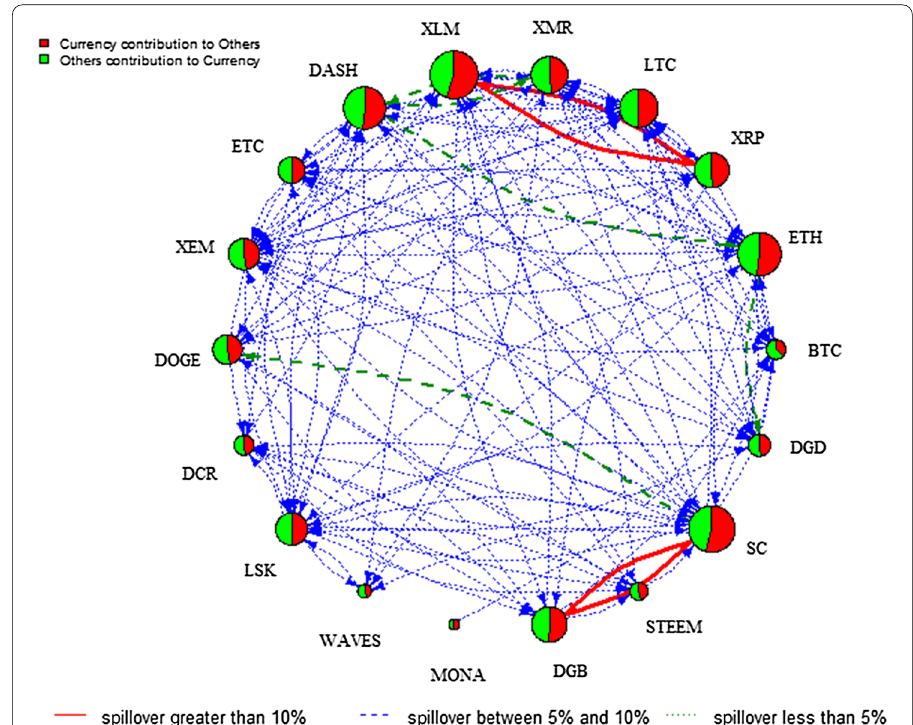
Fig. 2 DY Spillover—without Regime Switching. Notes : This network graph illustrates the degree of total connectedness in a system that consists of the 18 cryptocurrencies over the full sample period. Total connectedness is measured using the Diebold–Yilmaz framework. The size of the node shows the magnitude of the contribution of each variable to system connectedness, while the colour indicates the origin of connectedness. In particular, red implies a contribution from the variable under consideration to the other variables of the system and green means a contribution from the other variables to the variable under analysis. The colour and thickness of edges refers to the strength of the connectedness. Specifically, arrows in red full lines indicate that the magnitude of the connectedness is greater than 10%, arrows in green dashed lines imply that the strength of the connectedness is between 5 and 10%, blue dotted lines are associated with connectedness between 1 and 5%. Finally, connectedness lower than the 1% is not reported to preserve clarity in the